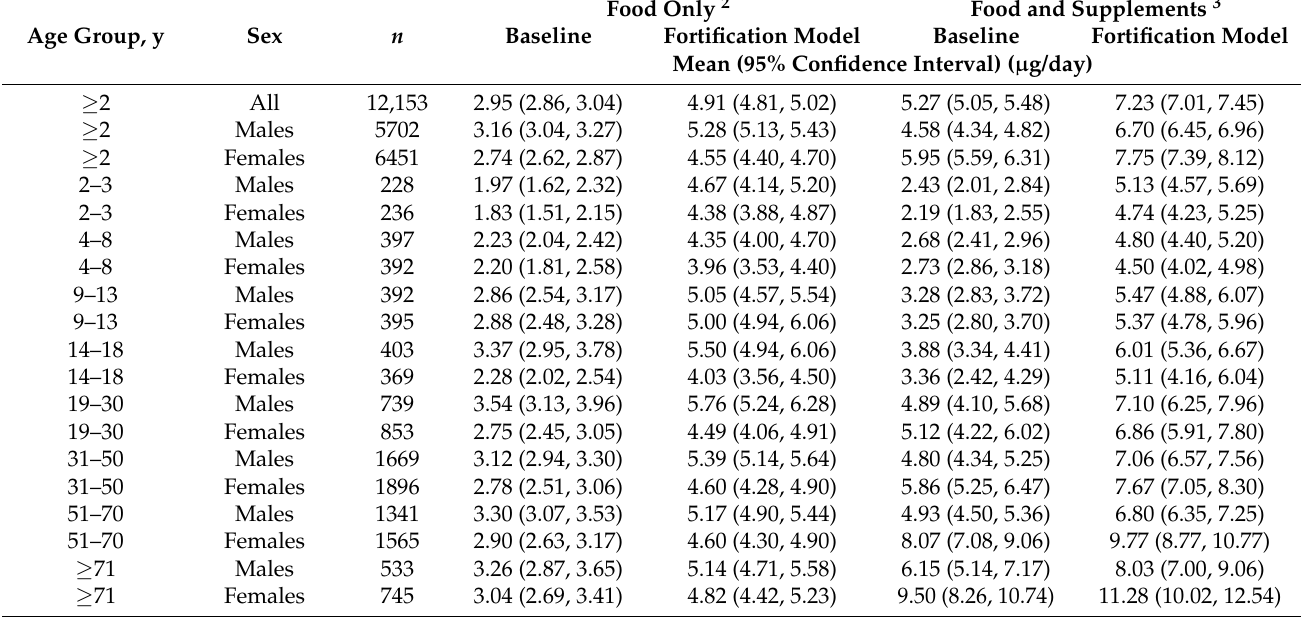
Table 1. Estimated vitamin D intakes 1 in a nationally representative sample of Australians at baseline and according to a vitamin D fortification scenario of 0.8 µ g/100 mL in fluid milks/alternatives. Food Only